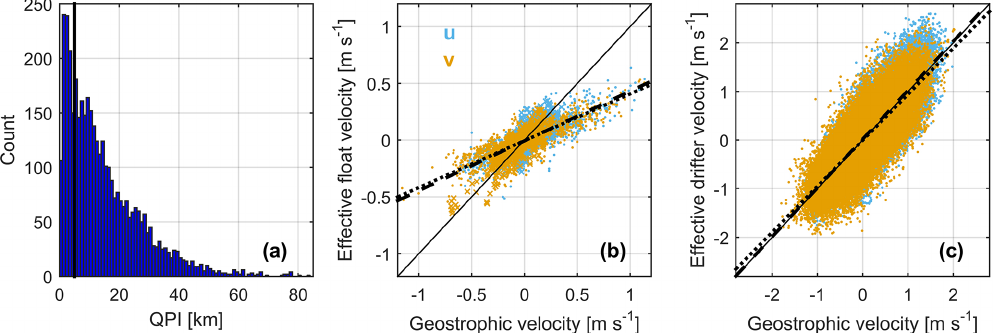
Figure 3. Overview of float velocities showing (a) a histogram of the quasi-planktonic index (QPI) for all float profiles (the black line indicates 5km) and (b) a scatter plot of effective float velocity (centred difference position) against the total surface geostrophic velocity projected onto the float track. Blue (orange) dots are for zonal (meridional) velocity, and similarly coloured x symbols are for profiles with a QPI < 5km. The solid line is the one-to-one line, and the dashed (dotted) line is the least-squares regression line for zonal (meridional) velocity. Panel (c) is the same as panel (b) but for